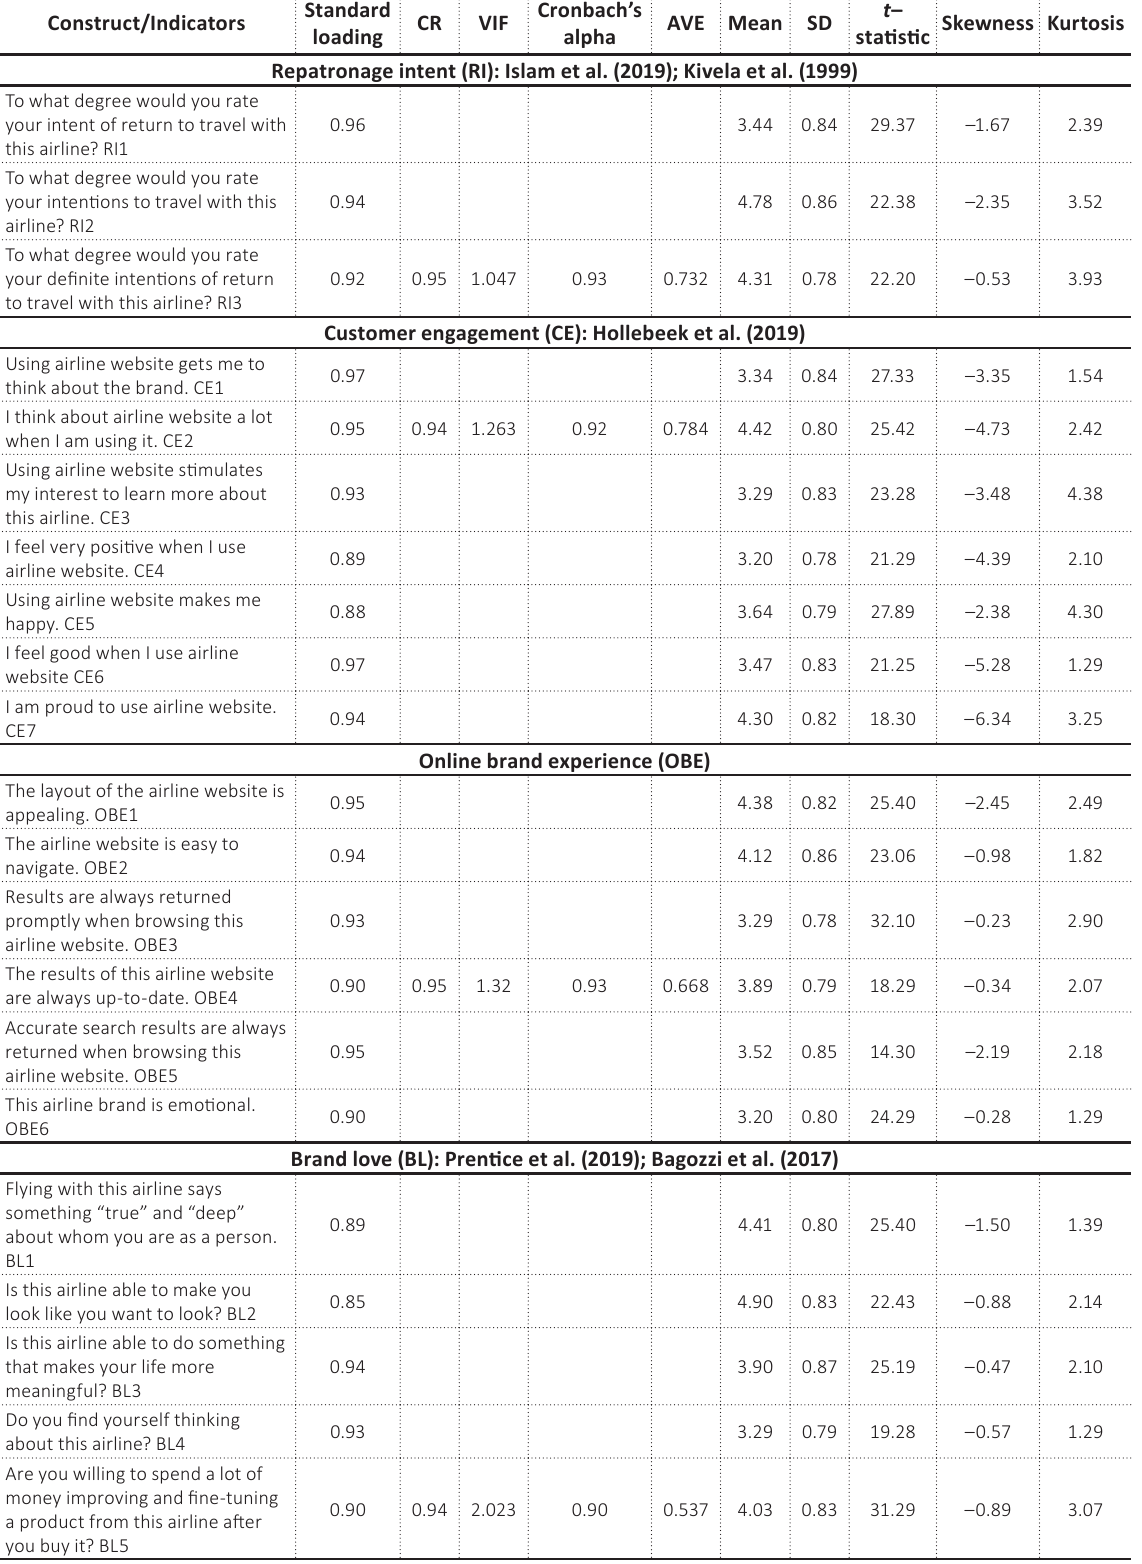
Table A1. Measurement statistics of construct